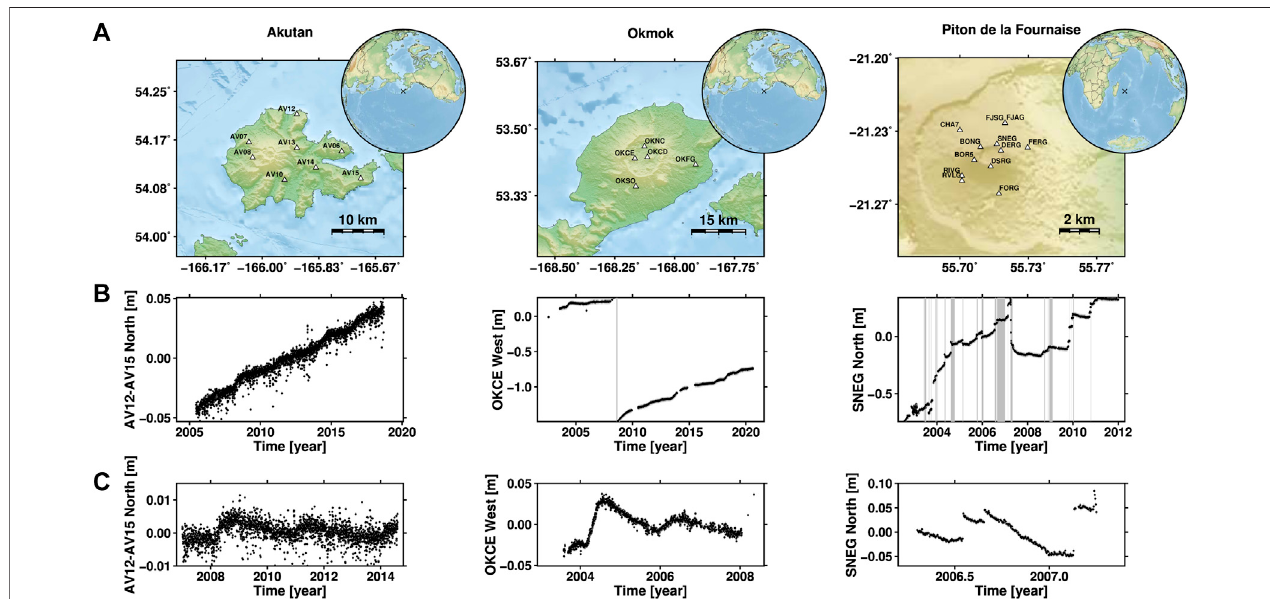
FIGURE2| LocationmapandselectedtimeseriesofGPSdisplacementforthethreevolcanoesusedinthisstudy. (A) :Maps, withgreytrianglesshowingtheGPS sitesfromwhichthedisplacementtimeseriesusedhereinhavebeenextracted; (B) :Fulltimeseriesavailable,including lineartrend; (C) :Selectedtimeinterval,withlinear trend removed. The selected sites and directional components are indicated on the ordinate of the (B,C) . For instance, for Akutan, AV12-AV15 North indicates the difference between the northward GPS displacements at sites AV12 and AV15. Grey vertical bars in the middle panels indicate intervals of eruptive activity.